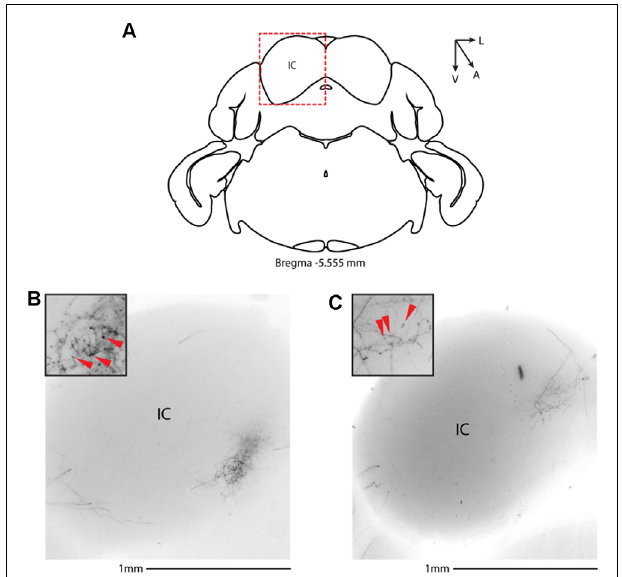
FIGURE 3 | Subcortical target of long-range VIP-expressing neurons: midbrain. (A) Allen Brain reference coronal section at − 5.555 mm from Bregma. Red dashed squares indicate the region imaged in the panels below. (B,C) Two examples of the inferior colliculus, from two animals. Scale bars: 1 mm. Insets indicate axonal branches and the red arrowheads boutons. Inset size 190 µ m. IC, inferior colliculus.